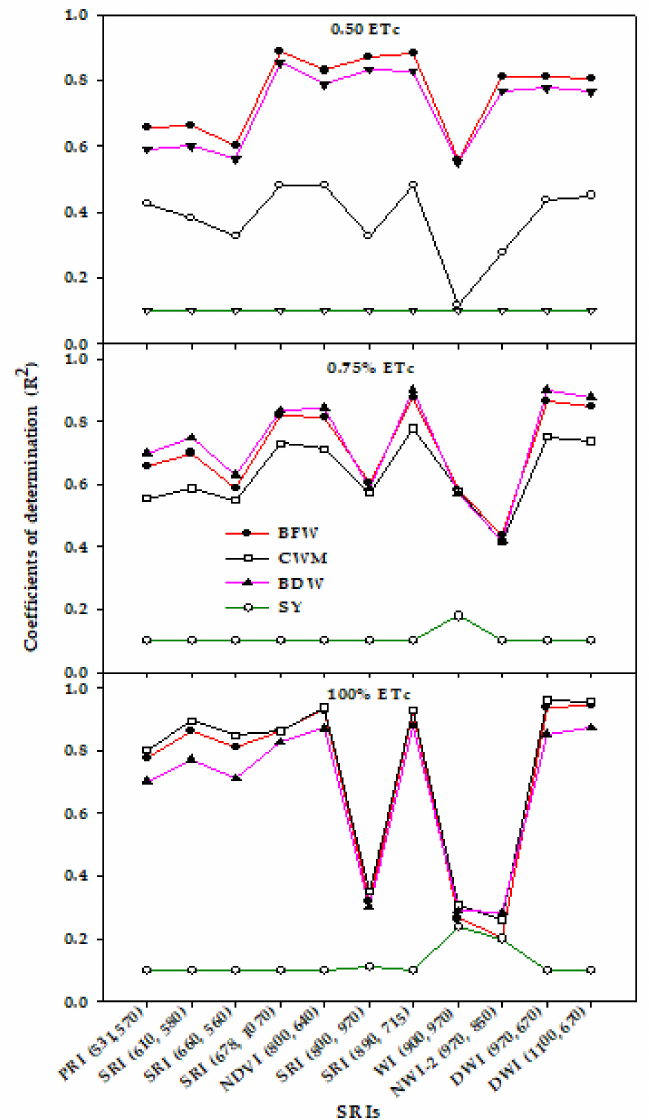
Figure 4. Coe ffi cients of determination (R 2 ) for the relationship between di ff erent spectral reflectance indices (SRIs) and vegetative growth traits (biomass fresh weight (BFW), biomass dry weight (BDW), canopy water mass (CWM), and seed yield (SY)) for each irrigation regimes across two growth stages ( n =